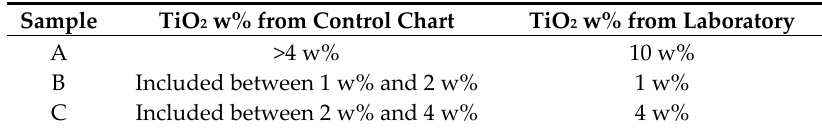
Figure 5. Control chart based on fitting curves (quadratic polynomials) reported in Figure 4. Curve for TiO 2 8 w% has been neglected, because it is not statistically different to 4 w% that, hence, only one area was identified with TiO 2 w% > 4%. Table 2. Comparison between TiO 2 amounts provided by laboratory and valued through the control chart (cf. Figure 5) on three samples with unknown TiO2 weight